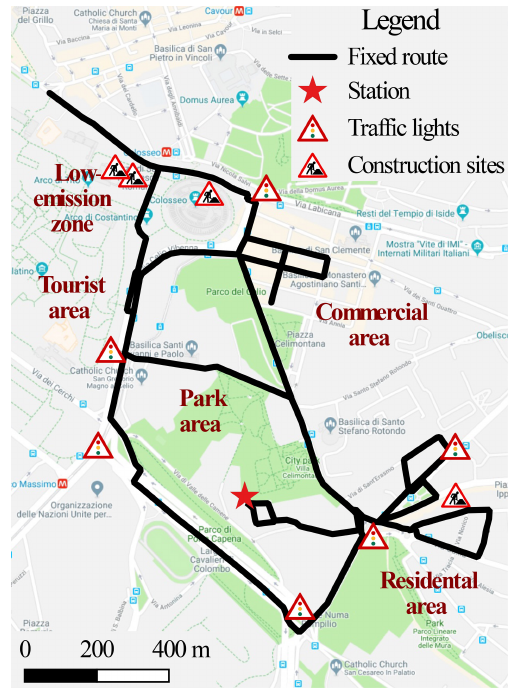
Figure 2. Illustration of the fixed mobile measurement route with labels of the different microenvironments. Map data © Google Maps